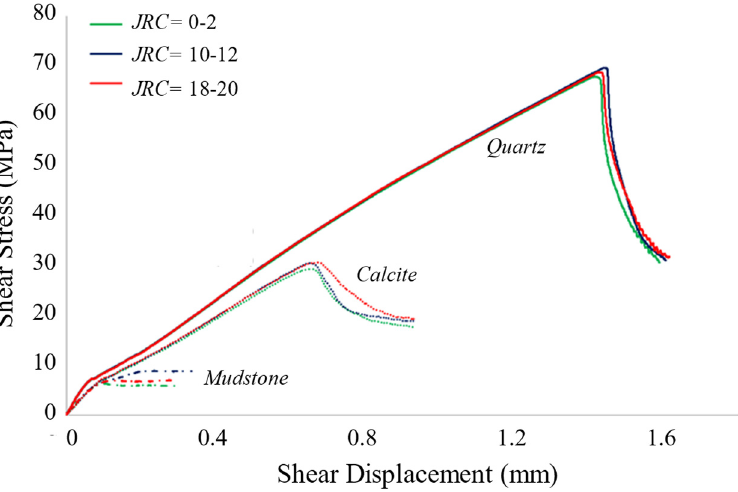
Figure 21. Shear strength of quartz, calcite, and mudstone–infilled specimens with varying infill JRC under 0.5 MPa σ n .